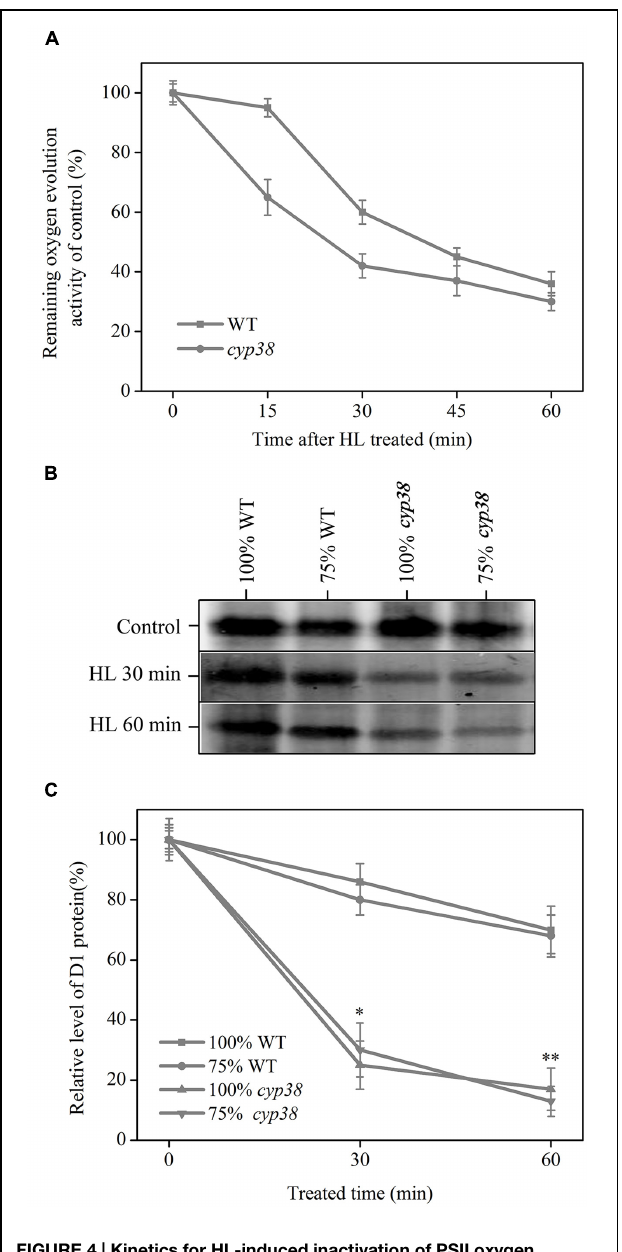
FIGURE 4 | Kinetics for HL-induced inactivation of PSII oxygen evolution and D1 protein degradation in WT and cyp38 mutant. (A) Relative levels of oxygen evolution activity in isolated thylakoid membranes of WT and cyp38 mutant. (B) Immunoblot of the D1 protein isolated from WT and cyp38 plants. Thylakoid membranes sample content 0.2 µ g chlorophyll was set to 100%. (C) Quantitative analysis of the result in (B) . The standard deviations were calculated for data obtained from three independent experiments. Asterisks ( ∗ ) indicate a significant difference from the Control at ∗ P < 0.05, ∗∗ P < 0.01.